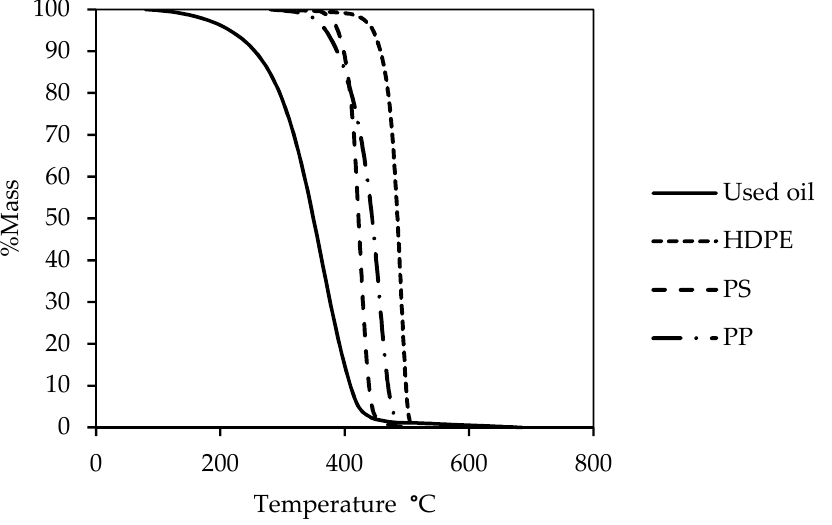
Figure 3. TGA analysis of the co-pyrolysis materials. Table 2. Feedstock characteristics.